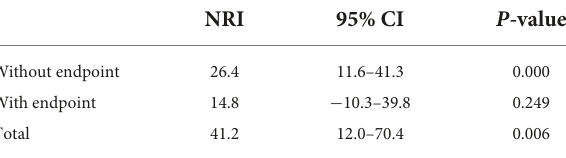
TABLE 4 Net reclassification index (NRI) for outcomes of death/myocardial infarction (MI) at 6 months adding